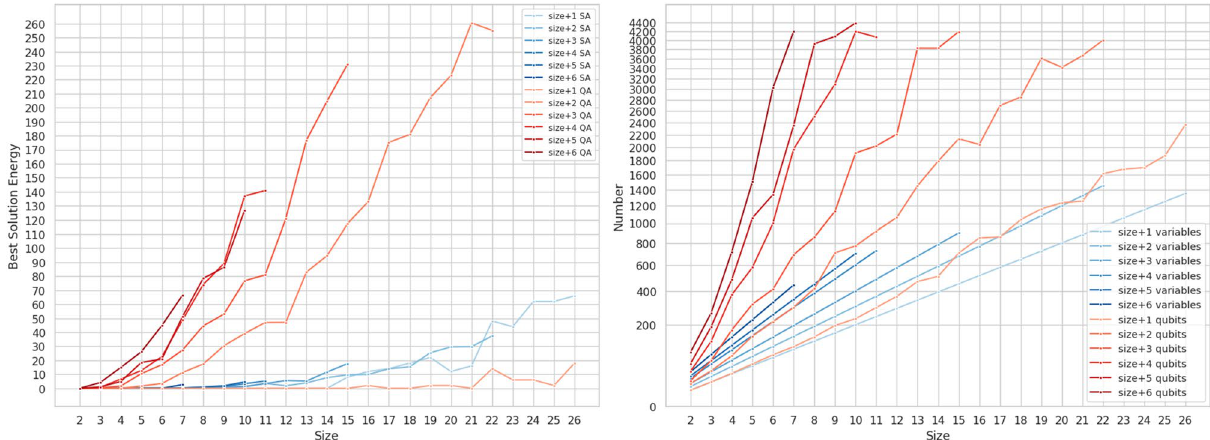
Figure 4. Visualization of the solution energy as well as the and number of variables and qubits required for JSSP instances with known solution of increasing size and timespan window, from size + 1 to size + 6 . Results refer to the Advantage QPU, missing values indicate the instance did not fit on the QPU. ( Left ) Best solution obtained with Simulated Annealing (SA) and Quantum Annealing (QA). ( Right ) Semi-logarithmic plot of the QUBO variables and the qubits needed to embed